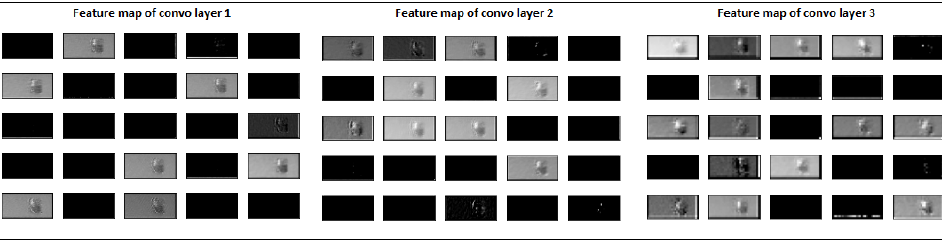
Figure 14. Feature maps of defective layer image 450 after each convolutional